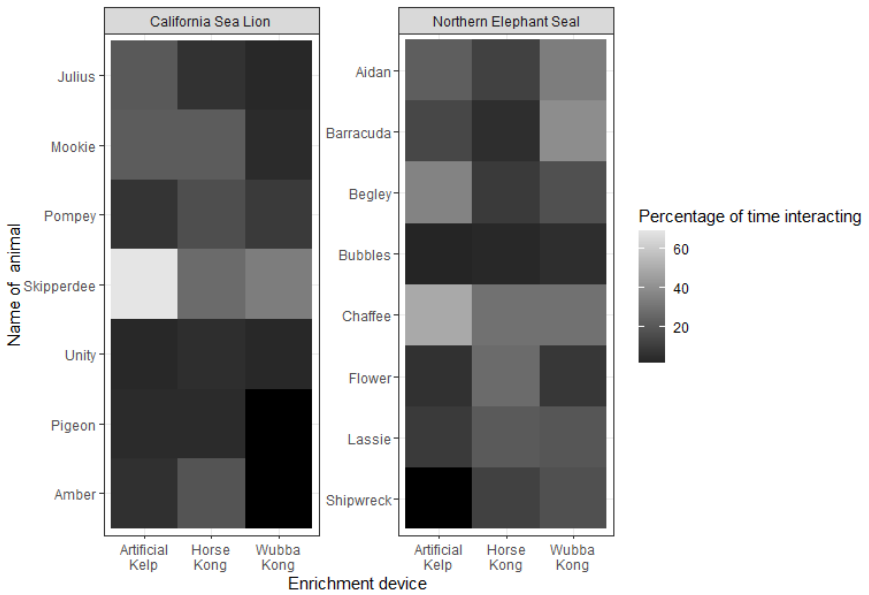
Figure 4. Heatmap of the percentages of individual use of environmental enrichment devices per species during presentation sessions. Black = no interaction.